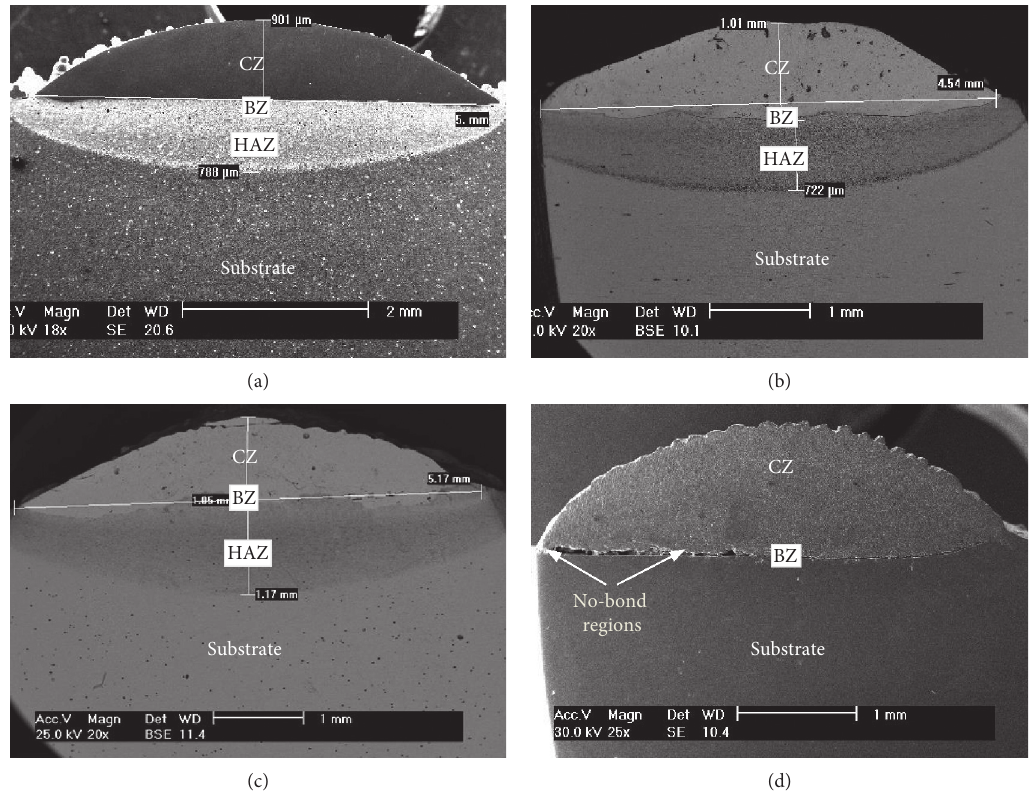
Figure 3: Microstructure of coatings. (a) S0 coating. (b) S1 coating. (c) S2 coating. (d) S3 coating (BZ: bonding zone; CZ: cladding zone; and HAZ: heat affected